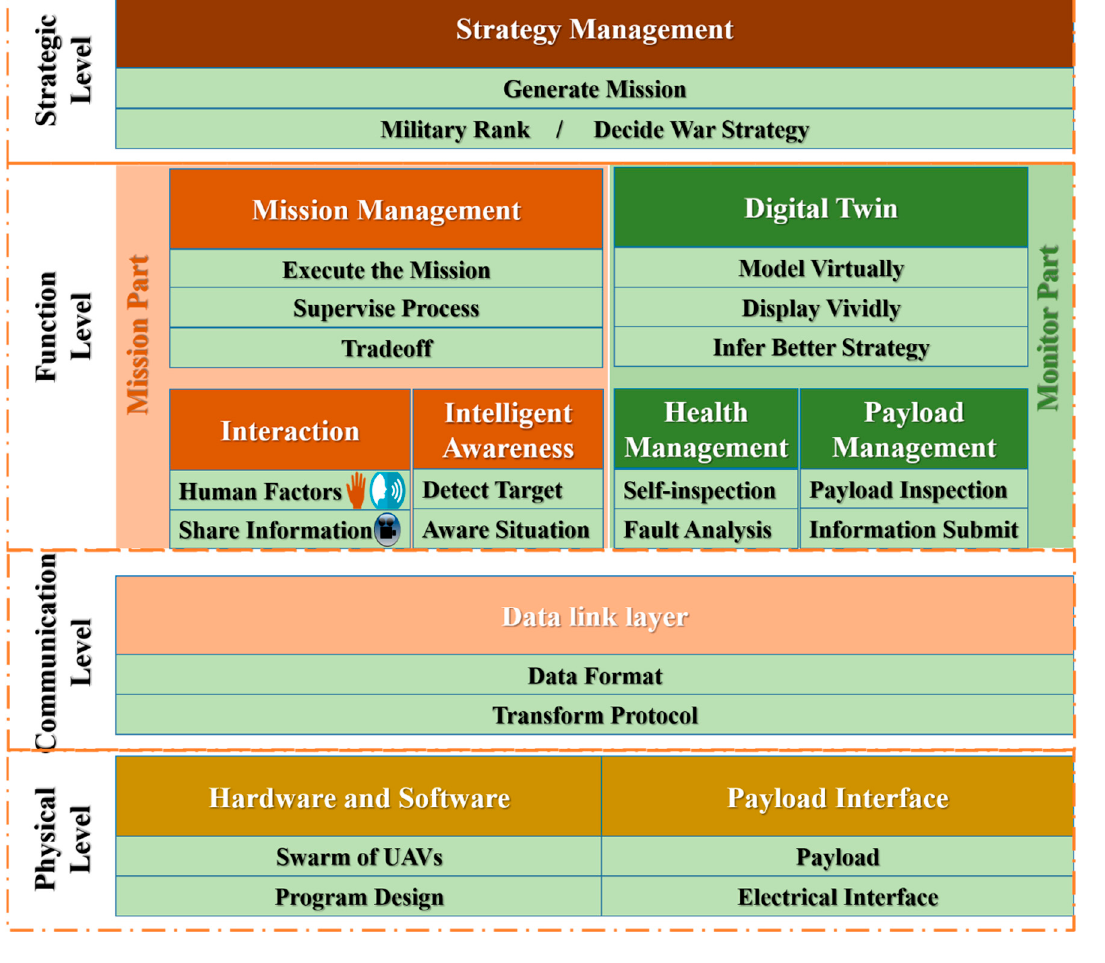
Figure 2. The architecture of UAV system. It is designed for the flock of UAVs and the overall system is composed of four levels: physical, communication, function, and strategy. This paper focuses on the Intelligent Awareness in the Function Level to empower the UAV with the capacity of understanding the environment.